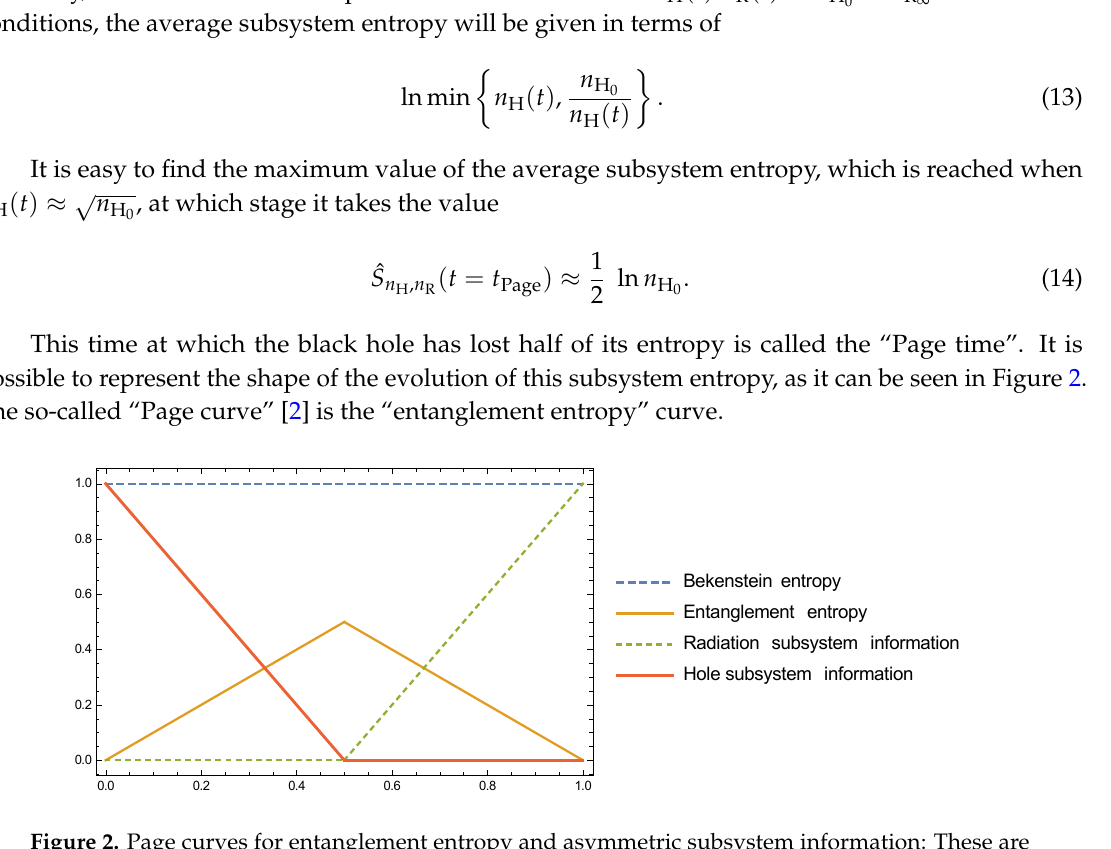
Figure 2. Page curves for entanglement entropy and asymmetric subsystem information: These are derived under the “average subsystem” assumption applied to a pure-state bipartite system consisting only of (black hole) plus the (Hawking